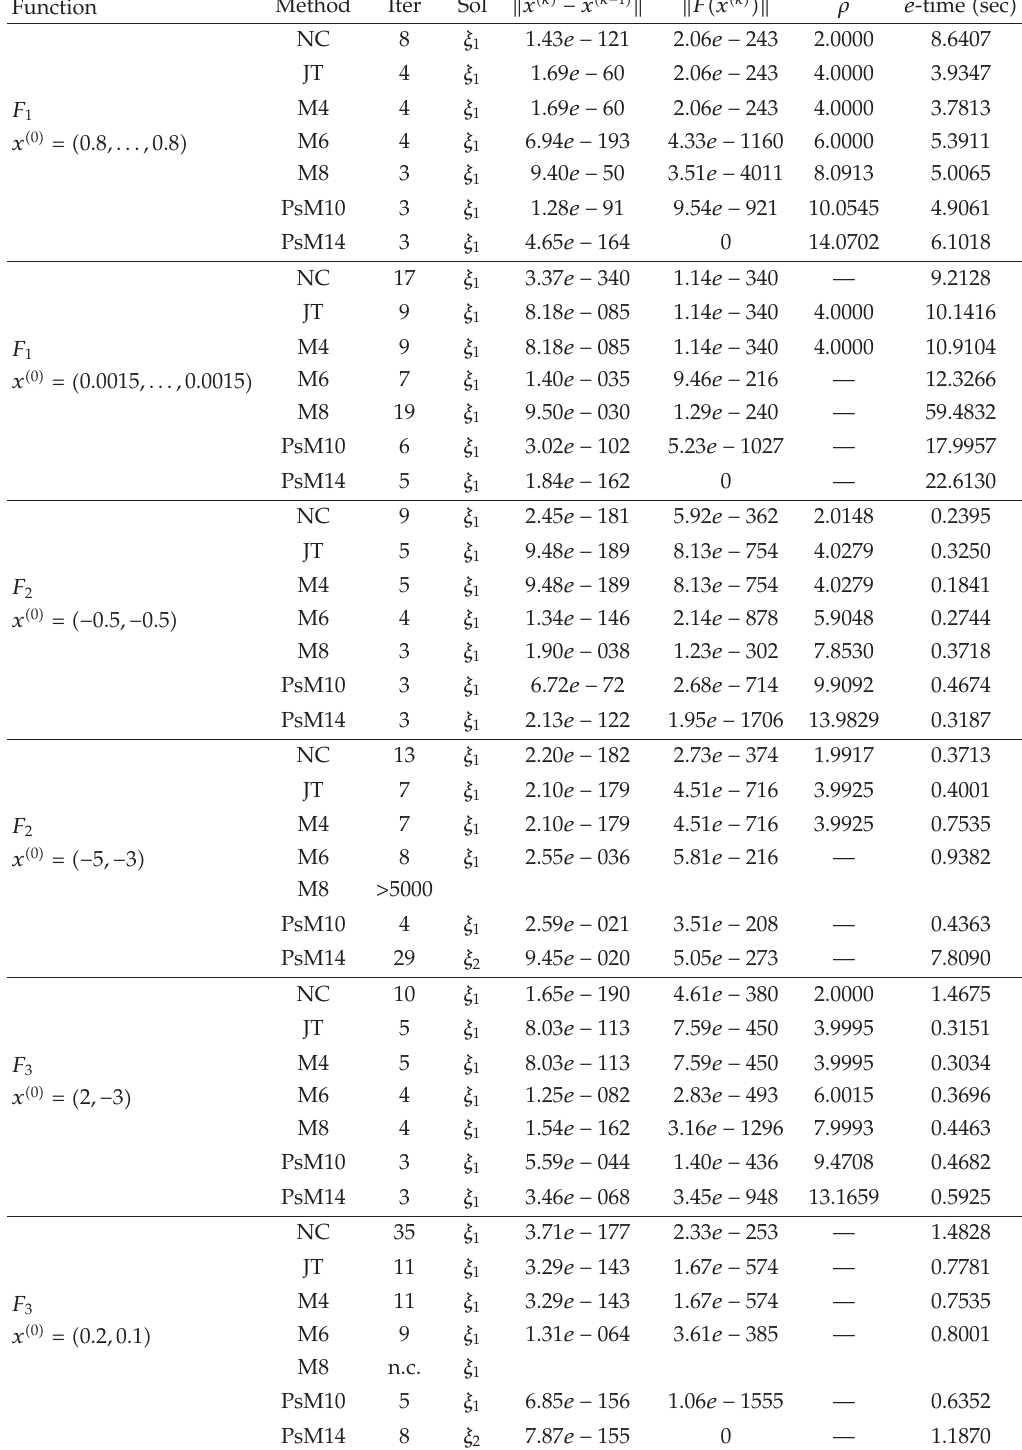
Table 2: Numerical results for functions F 1 to F 4